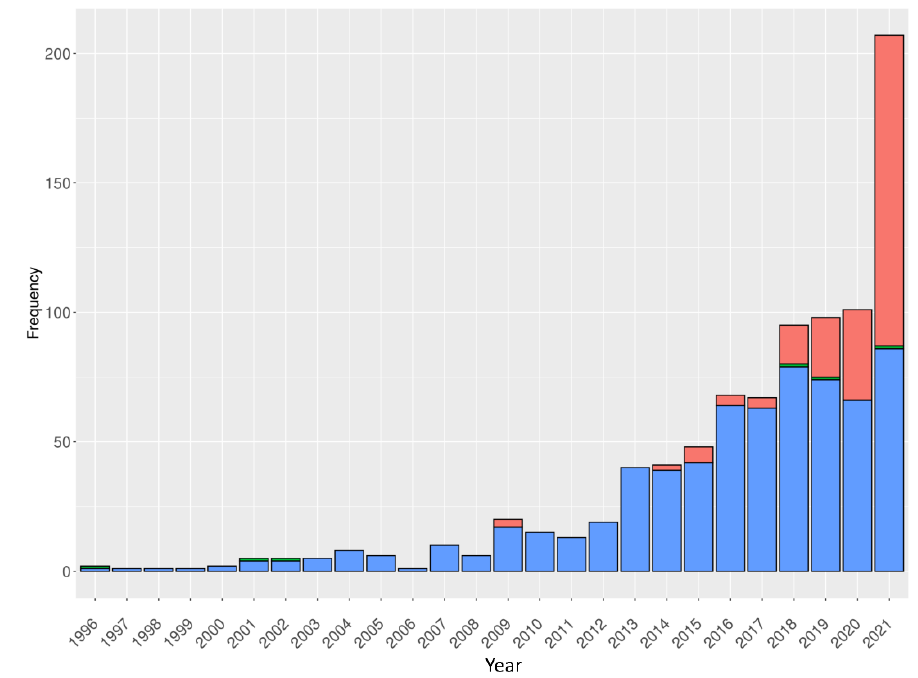
Figure 4. Number of V H H structures deposited in the PDB per year. Structures solved using different experimental methods are colour-coded accordingly (electron microscopy, solution NMR and X-ray diffraction has been represented in red, green and blue respectively). Data extracted from Reference [159].